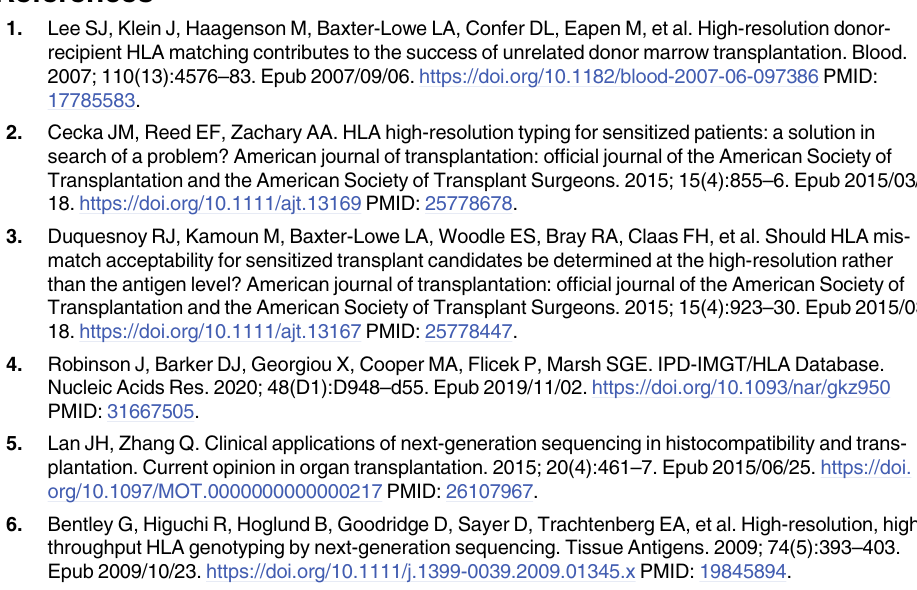
S20 Table. HLA-DQB1 allele frequencies of 16 populations. S21 Table. HLA-DPA1 allele frequencies of 10 populations. S22 Table. HLA-DPB1 allele frequencies of 14